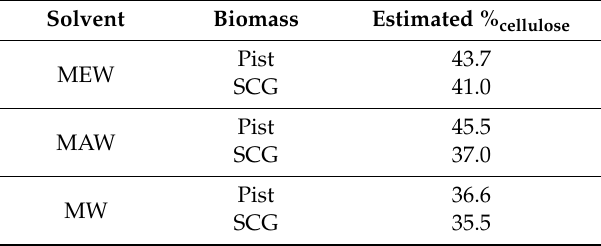
Figure 10. Thermogravimetric analysis (TGA) of CEF samples from pistachio hull and SCG. Table 7. Percentage of cellulose and ash in CEF samples based on TGA.